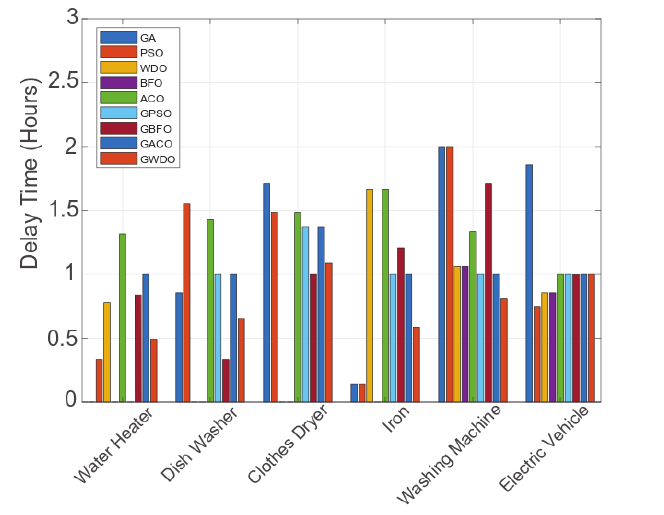
Figure 12. Case study 2: User comfort evaluation. Table 4. Comparison of the proposed model with existing models from different